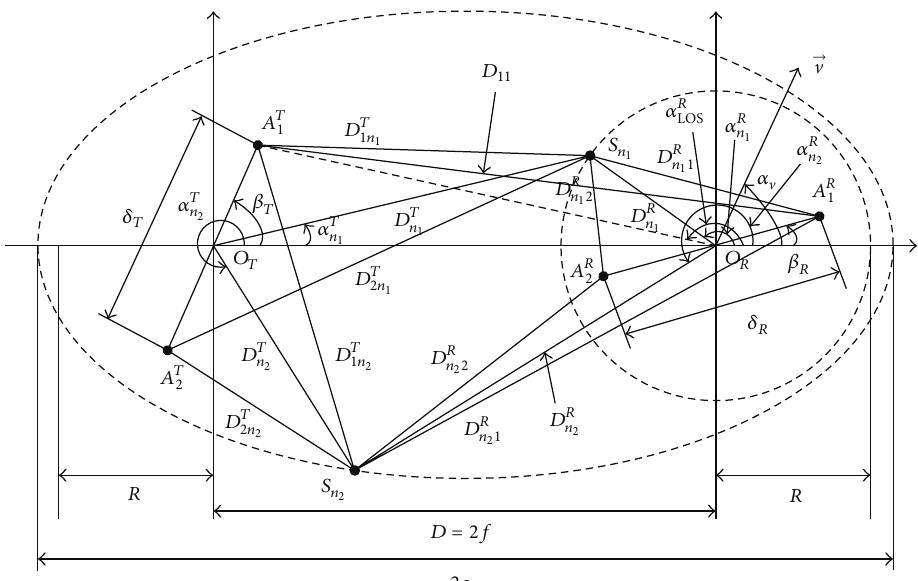
Figure 7: The geometrical model for a 2 × 2 MIMO